Question: From the figure, is the trend upward or downward?
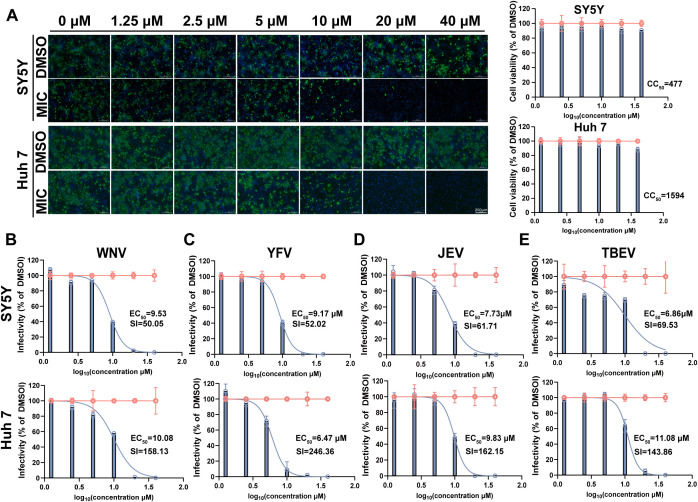
Answer: increasing